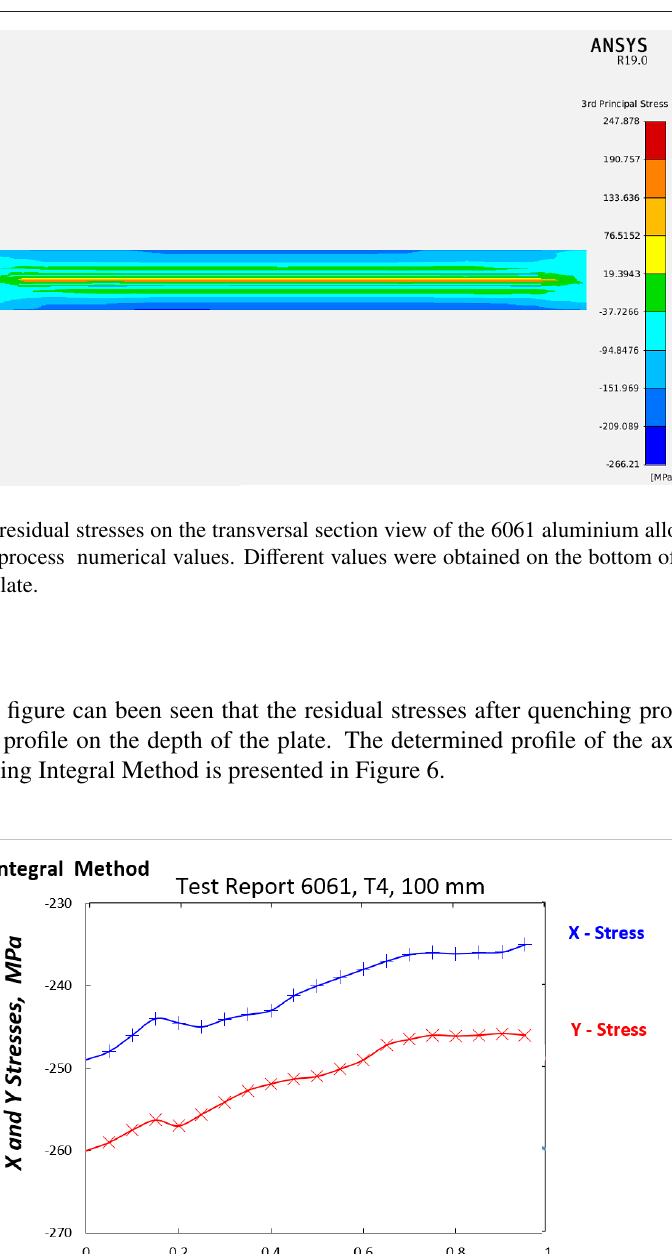
The values obtained for the residual stresses on the bottom surface of the plate were similar to those obtained by using ANSYS software.